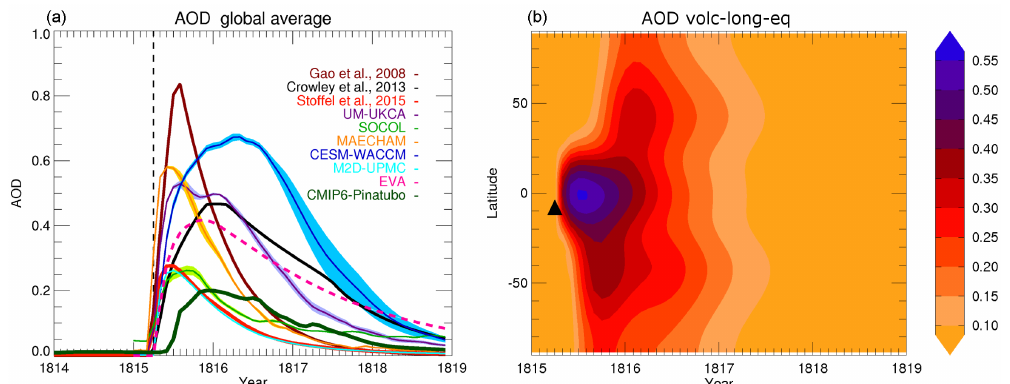
Figure 3. (a) Uncertainty in estimates of radiative forcing parameters for the 1815 eruption of Mt. Tambora: global-average aerosol optical depth (AOD) in the visible band from an ensemble of simulations with chemistry–climate models forced with a 60Tg SO 2 equatorial eruption, from the Easy Volcanic Aerosol (EVA) module with 56.2Tg SO 2 equatorial eruptions (magenta thick dashed line), from Stoffel et al. (2015), from Crowley and Unterman (2013), and from Gao et al. (2008, aligned so that the eruption starts on April 1815). The estimate for the Pinatubo eruption as used in the CMIP6 historical experiment is also reported for comparison. (b) Time–latitude plot of the AOD in the visible band produced by EVA for a 56.2Tg SO 2 equatorial eruption, illustrating the consensus forcing for the volc-long-eq experiment. The black triangle shows latitudinal position and timing of the eruption. Chemistry–climate models are CESM (WACCM) (Mills et al., 2016), MAECHAM5-HAM (Niemeier et al., 2009), SOCOL (Sheng et al., 2015), UM-UKCA (Dhomse et al., 2014), and CAMB-UPMC- M2D (Bekki, 1995; Bekki et al., 1996). For models producing an ensemble of simulations, the line and shading are the ensemble mean and ensemble standard deviation